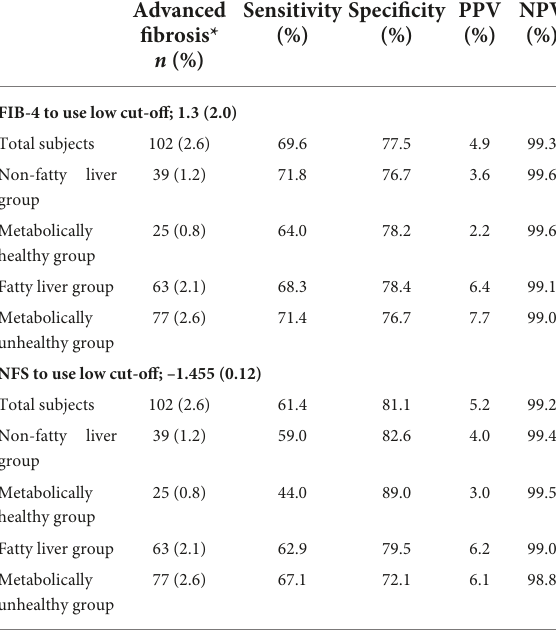
TABLE 2 Comparison of FIB-4 and NFS for diagnostic performance of advanced hepatic fibrosis in various groups.